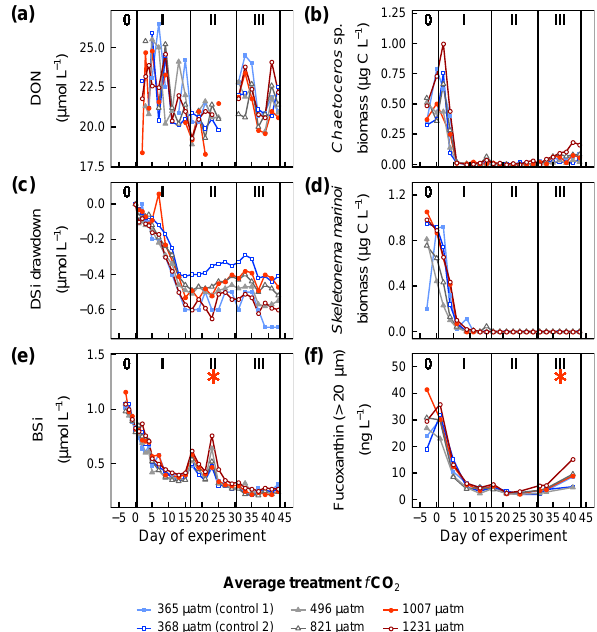
Figure 2. Temporal development in (a) dissolved organic nitrogen concentrations (DON), (c) dissolved silicate (DSi) drawdown and (e) particulate biogenic silicate (BSi) concentrations (data from Paul et al., 2015), the abundances of the two dominant diatom species determined by microscopy (b, d) and (f) , Fucoxanthin marker pig- ment concentrations (>20µm), a key pigment in diatoms. The red asterisk denotes significant positive effect of CO 2 (* = p< 0 .